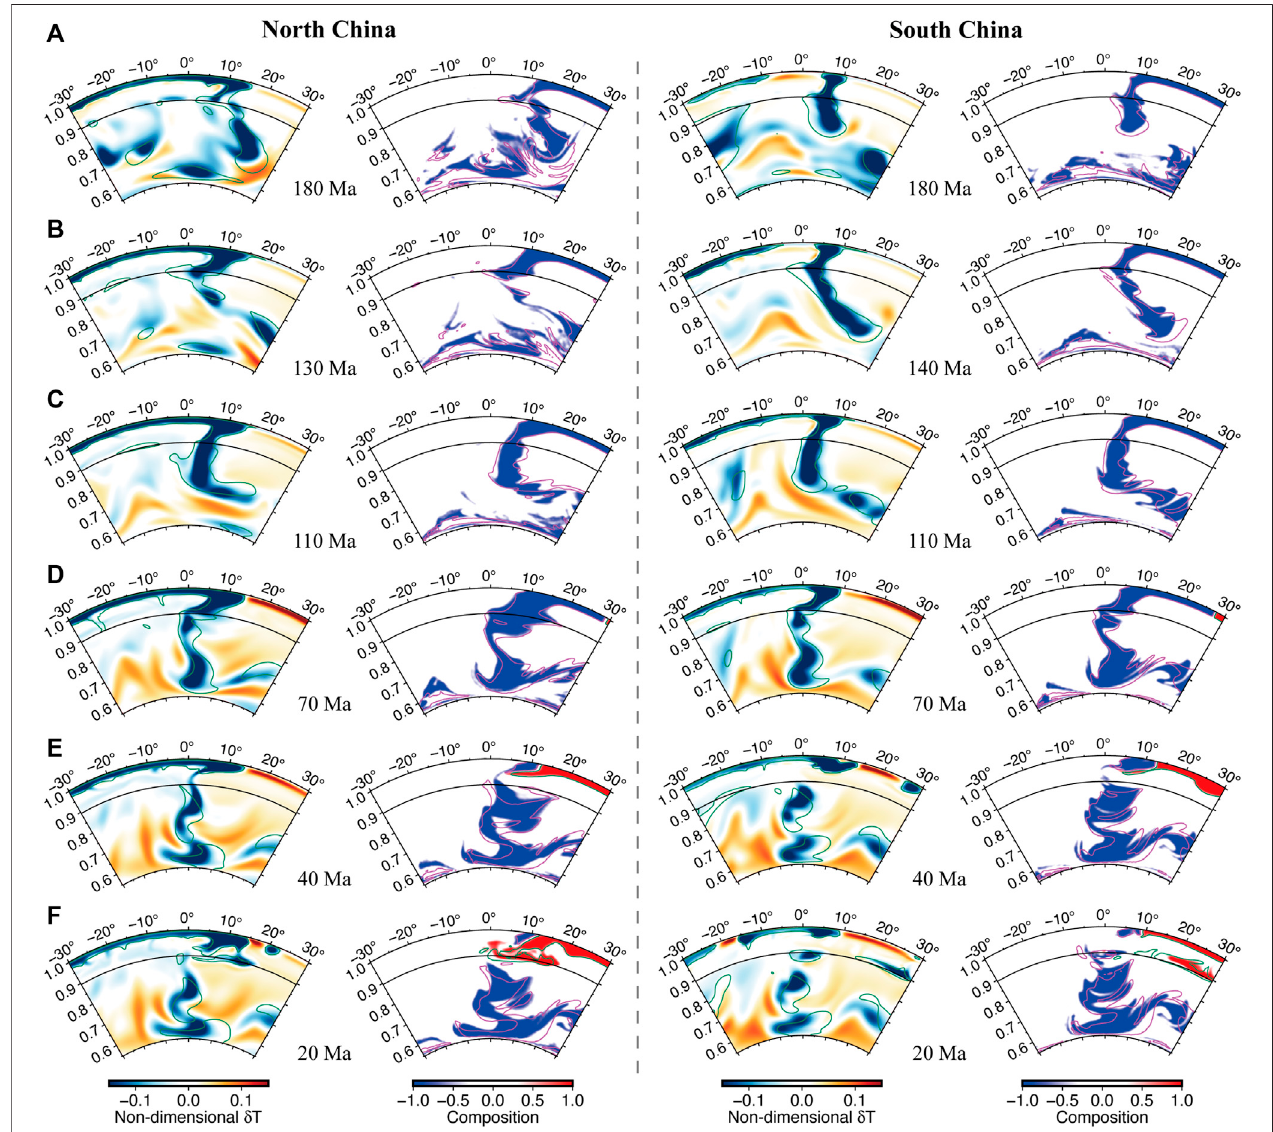
FIGURE 8 | Slab structures of the Izanagi-Paci fi c Plate beneath the North China Craton (left columns) and the South China Block (right columns) at some time snapshots for case 5. In (A – F) , the left and right columns are cross-sections of the residual temperature and composition fi elds across the NCC and the SCB, respectively. Line descriptions are the same as those in Figure 5